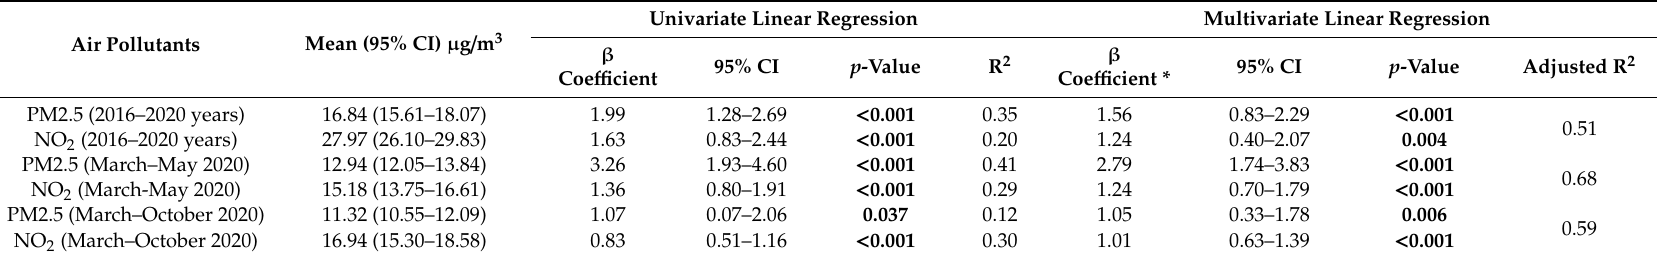
Table 2. Univariate and multivariate linear regression analysis with logarithmic transformation for the associations between COVID-19 incidence rates and the explanatory variables (PM2.5 and NO 2 average